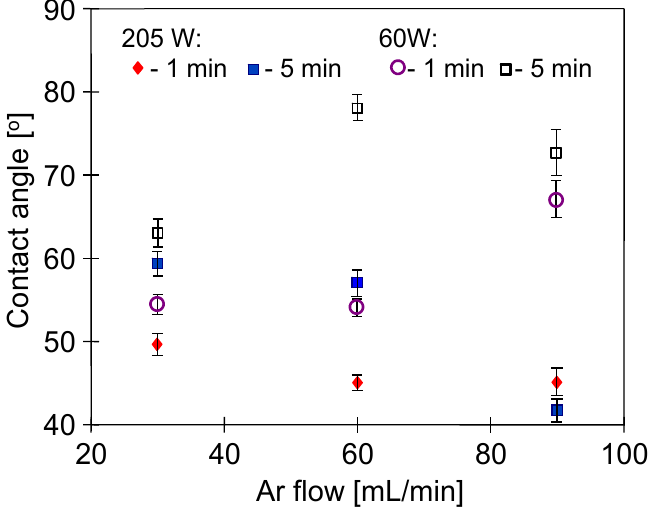
Figure 2. Effect of Ar plasma excitation power on the contact angle of polypropylene (PP) foil. Ar flow rate: 90 mL/min.